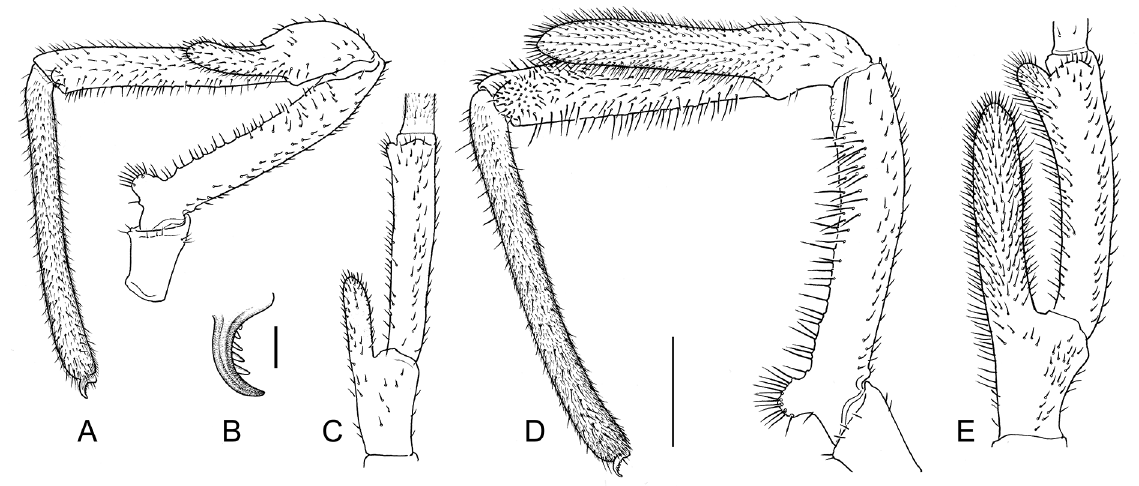
Fig. 22. Dicranopalpus catariegensis sp. nov. Right pedipalp. A – C . Male. D – E . Female. A , D . Median view. B . Claw. C , E . Dorsal view of patella and tibia. A–E (CJM 1746). D–E (CJM 9005). Scale bars: A, C–E = 0.5 mm; B = 50